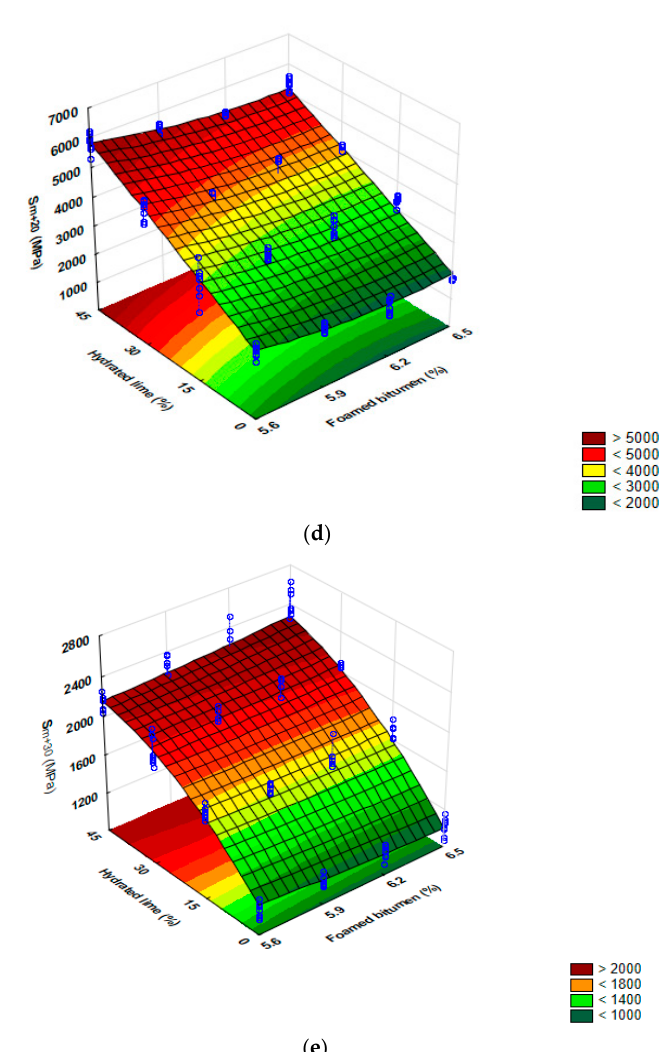
Figure 8. Stiffness modulus (S m ) as a function of test temperature and amount of foamed bitumen and hydrated lime; models describing these relationships. ( a ) S m-10 = 31,976.2 − 4250.8 FB + 535.1 FB 2 − 560.6 HL + 2.2 HL 2 + 100.4 FB HL, ( b ) S m0 = - 14,876.7 + 6178.5 FB − 203.2 FB 2 − 178.1 HL − 0.8 HL 2